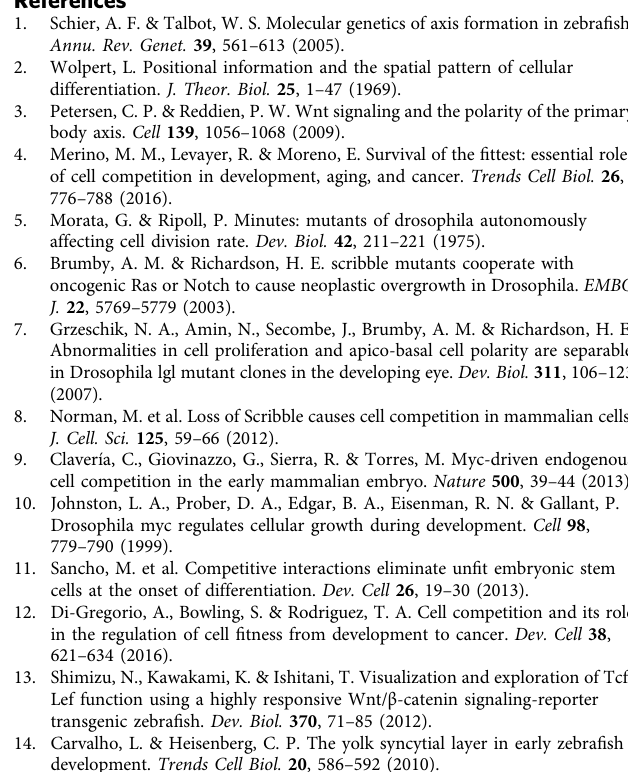
Fig. 7 Apoptotic elimination of un fi t cells is required for precise tissue patterning. a Sephs1 overexpression partially reduces physiologically occurring apoptosis in embryos as determined by caspase-3 immunostaining. Box plots of caspase-3-active cell number per embryo at 10 hpf stage show 75th, 50th (median) and 25th percentiles. Whiskers indicate minimum and maximum. Each dot represents one embryo ( n = 28 embryos, two independent experiments). **** p < 0.0001, ** p < 0.045 (one-way ANOVA). b Inhibiting ROS production distorts the Wnt/ β -catenin-gradient. Whole-mount in situ hybridization of d2EGFP in Tg(OTM:d2EGFP) embryos (dorsal view) injected with mKO2 (control), SOD1 , or sephs1 mRNA (800 pg) or treated with 100 μ M NAC. Magni fi cation of boxed area (black line) (right). Embryo percentages and numbers with similar expression patterns are shown. Red arrows: ectopic activation or inactivation areas. Scale bar, 200 μ m. p < 0.05 for NAC treatment versus control; p < 0.01 for SOD1 or sephs1 mRNA versus control (Fisher ’ s exact test). c Inhibition of ROS-mediated apoptosis distorts AP patterning. Panels show whole-mount in situ hybridization of otx2 (marker of presumptive forebrain and midbrain), pax2a (marker of presumptive midbrain-hindbrain boundary), and cdx4 (marker of presumptive spinal cord) in embryos uninjected or injected with mKO2 (control), p35 , sephs1 , or SOD1 mRNA (800 pg). Scale bar, 200 μ m. Bottom schematic illustration indicates expression pattern of AP tissue markers. Right graphs show percentages of embryos with normal or abnormal expression patterns. In abnormal embryos, a posterior marker ( cdx4 ) and anterior markers ( pax2a and otx2 ) are ectopically activated in the anterior and posterior areas, respectively. d Overexpression of SOD1 or sephs1 mRNA induces abnormal morphogenesis. Images show 32 hpf zebra fi sh larvae uninjected or injected with SOD1 or sephs1 mRNA (800 pg). Red arrow indicates abnormal cell proliferation. Scale bar, 500 μ m. Percentages of embryos with normal or abnormal morphology are shown. The numbers shown above the graph indicate the total numbers of embryos analysed. ** p < 0.01 (Fisher ’ s exact test). Note that a portion of embryos showed the anteriorization-related phenotype (e.g. short trunk and tail) or posteriorization-related phenotype (e.g. head- and eye-size reduction). A small number of embryos generated a tumour-like cell mass (arrows). e Schematic diagram of the Wnt/ β -catenin-noise cancelling system. See also Supplementary